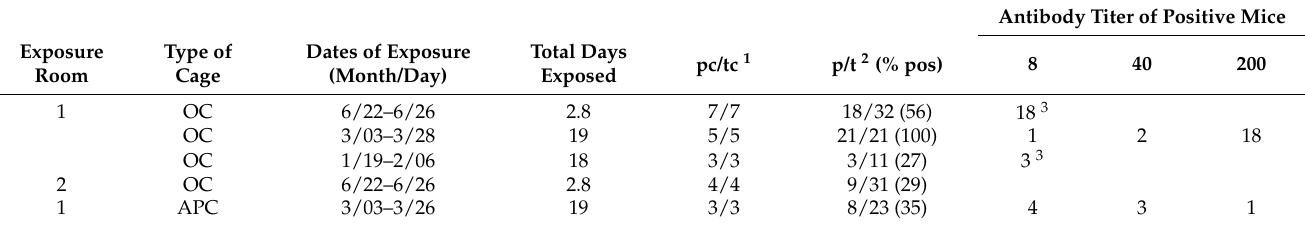
Table 4. Seropositivity among sentinel mice exposed in arthropod-proof cages (APC) and open cages (OC) in Kaeng Khoi cave,